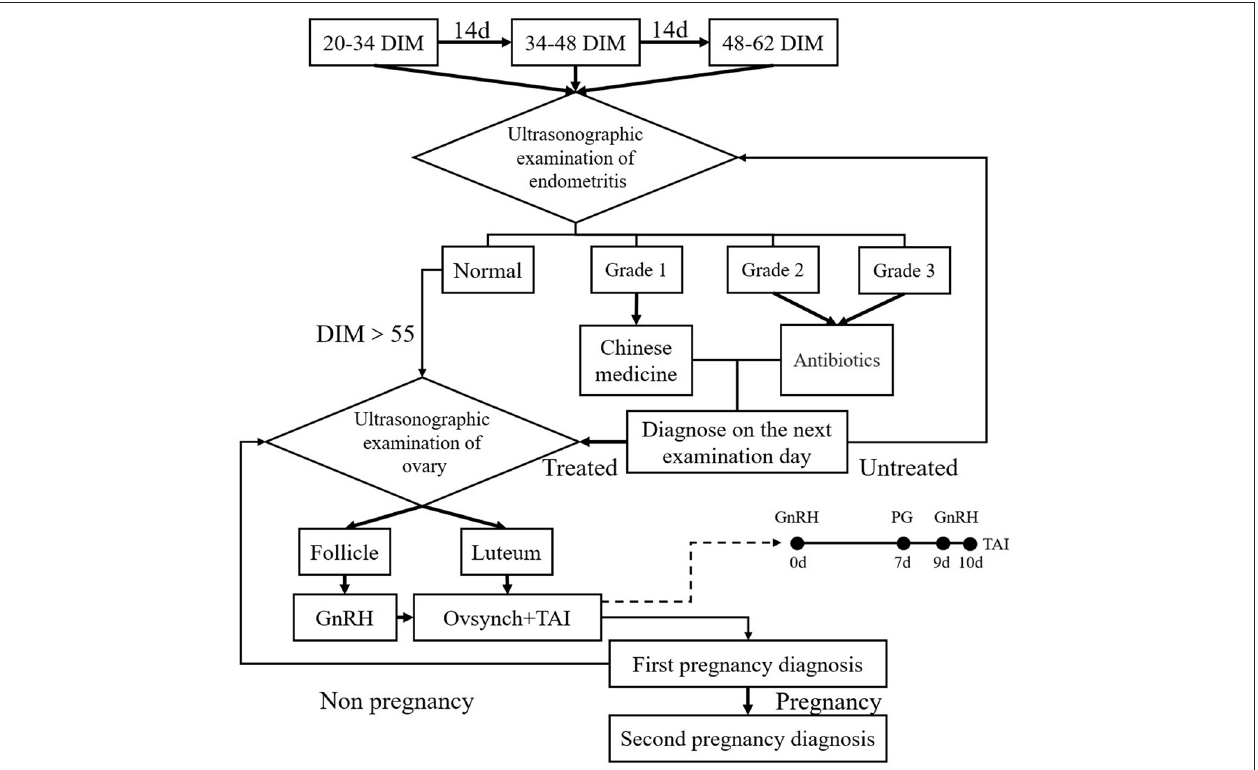
FIGURE 1 | Schematic diagram of the M + C program. Each cow underwent three regular reproductive organ inspections before insemination. The first inspection was performed at 20–34 days in milk (DIM). B-mode ultrasonography was used to examine the uterus and ovary transrectally and to take appropriate measurements under different conditions. After 14 and 28 days, the same examination and treatment were performed again. At 20–34, 34–48, and 48–62 DIM, the images for cow uterus size and abnormal fluid in uterus cavity were classified into four grades: normal and endometritis level I to III; Chinese medicine was used to treat cows with endometritis, and antibiotics were used to treat cows with endometritis level II or III. If a cow was diagnosed with endometritis during examination and treated, we waited 14 days until the next examination for diagnosis. In all cows with endometritis, TAI was performed only after endometritis was resolved. Then, if DIM was > 55 at this time, different treatment protocols were adopted for cows without abnormalities depending on their ovary phase. If the corpus luteum was mature with a still developing ovarian follicle in the cow ovary (i.e., the luteal phase), then we applied OvSynch + TAI; if the cow ovary had a mature ovarian follicle (i.e., the follicular phase), GnRH was used first, followed by OvSynch + TAI after 7